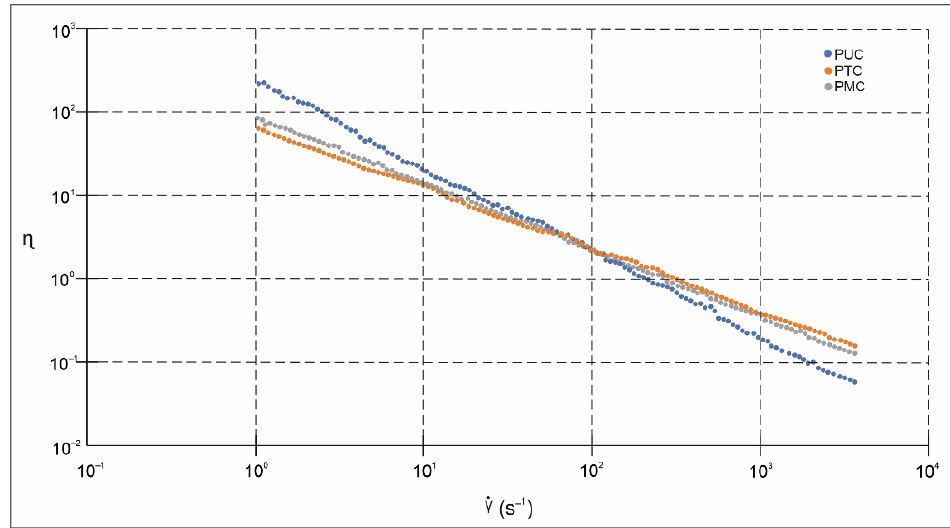
Figure 4. Shear rate-dependent viscosity of PUC, PTC, and PMC coatings.